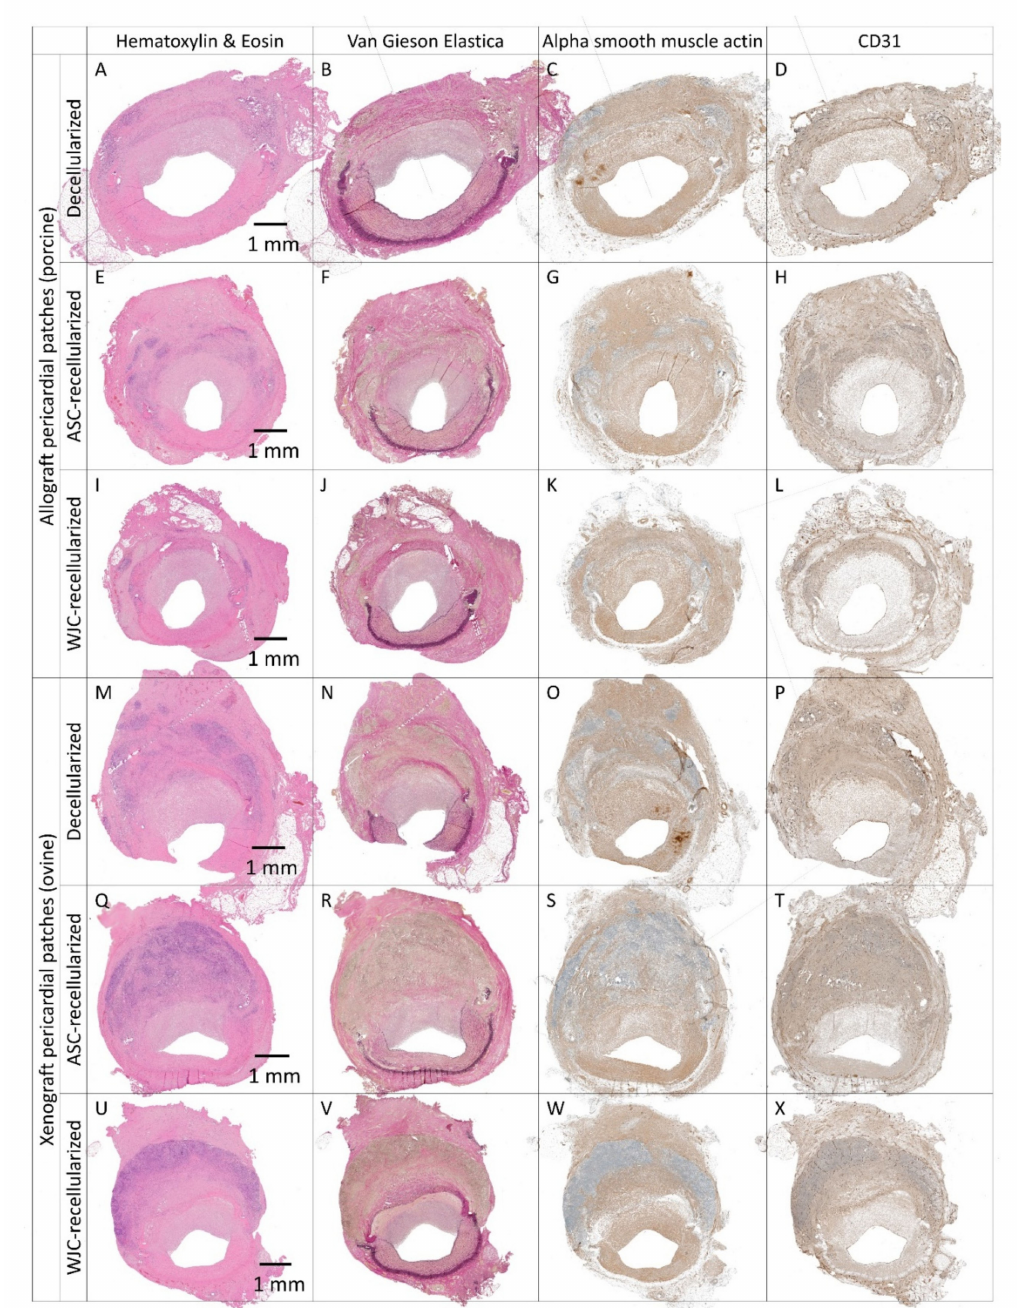
Figure 9. Histology and immunohistochemistry of experimental pericardial vascular patches in porcine carotid arteries 1 month post-implantation. We implanted decellularized ( A – D ) porcine allo- graft and ( M – P ) ovine xenograft patches, ( E – H ) allograft and ( Q – T ) xenograft patches recellularized with autologous adipose tissue-derived stromal cells (ASCs), and ( I – L ) allograft and ( U – X ) xenograft patches recellularized with allogeneic Wharton’s jelly mesenchymal stem cells (WJCs). Representative cross-sections of the midgraft regions are shown. Implanted patches comprise the upper half of the vessel, magnification 20 ×